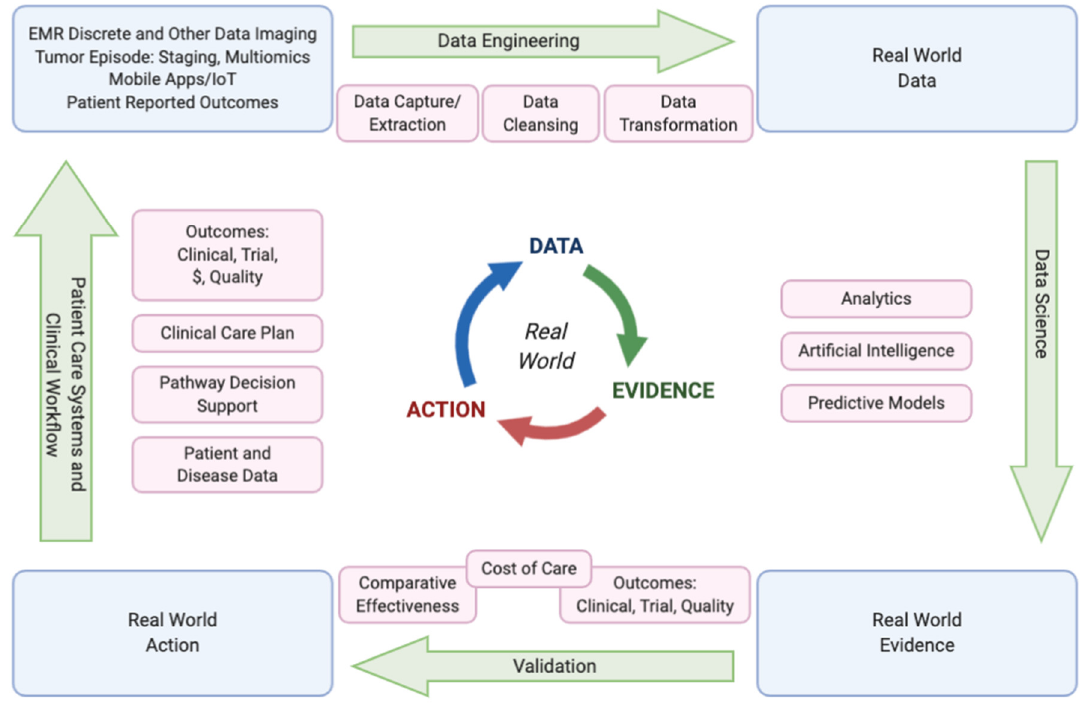
Figure 10. City of Hope’s overriding digital framework to empower value-based care and real-world insights.